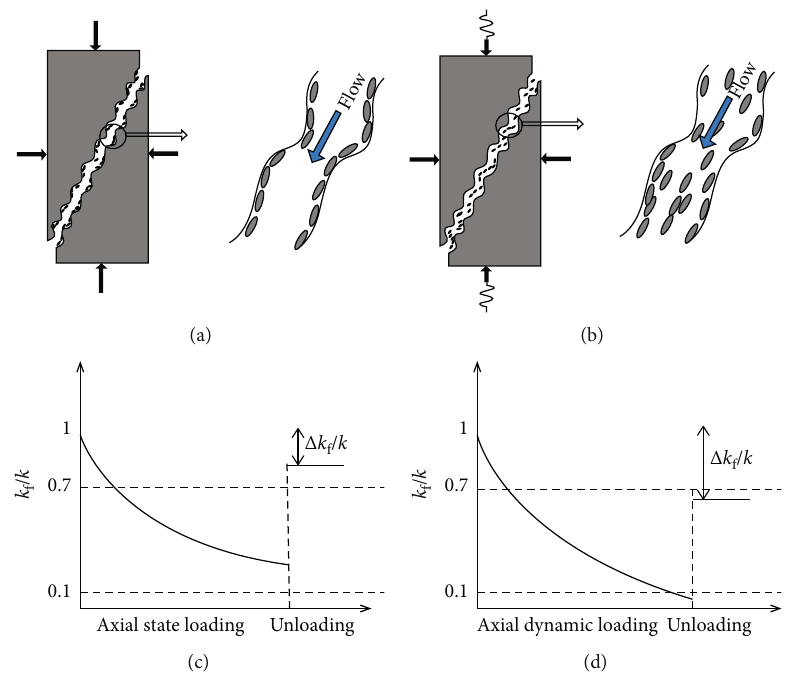
Figure 17: Permeability evolution modes of gouge material transport and fl ow mobilization. (a, b) Gouge material transport and fl ow mobilization under static stress and dynamic stress. (c, d) Permeability changes under static stress and dynamic